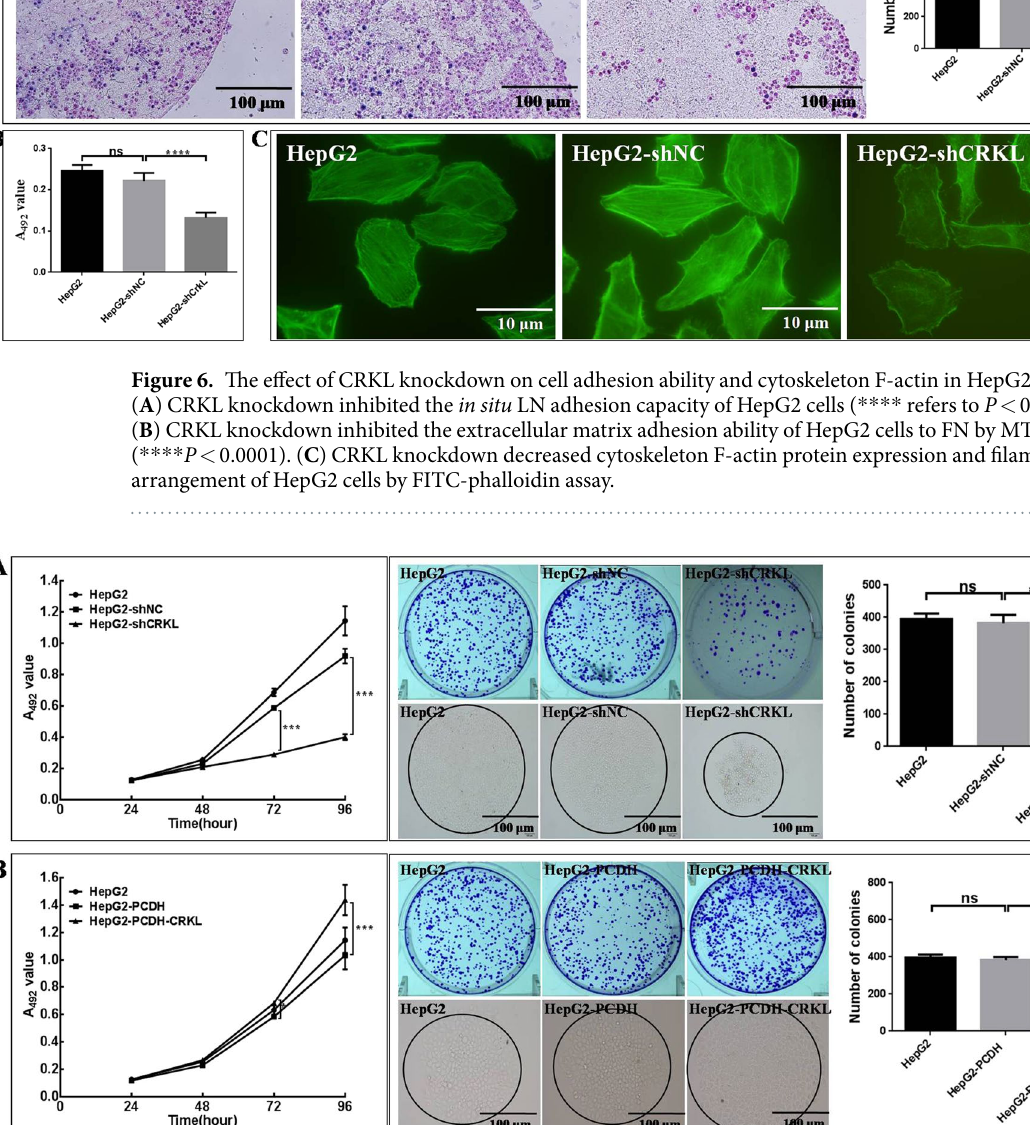
and increased N-cadherin (Fig. 9C) and Vimentin expression (Fig. 9D). miR-429 and CRKL are involved in the EMT of HCC. c-Jun signaling pathway is critical for cell growth. CRKL knockdown decreased and overexpression increased the mRNA level of c-Jun , while miR-429 overexpression and silencing showed no influence on c-Jun expres- sion (Fig. 10). Interestingly, CRKL knockdown or overexpression significantly decreased or increased the protein expression levels of c-Jun, p-c-Jun (73), p-c-Jun (243), JNK, p-JNK by 57.7%, 56.1%, 45.2%, 3.6-fold or 4.4-fold, 6.0-fold, 3.6-fold, 78.7%, 1.9-fold (Fig. 10). While, miR-429 overexpression or silencing only slightly decreased or increased the protein levels of c-Jun, p-c-Jun (73), p-c-Jun (243), JNK, p-JNK by 26.1%, 43.2%, 27.5%, 12.1%, 35.1% or 23.0%, 49.2%, 52.3%, 12.7%, 15.9% (Fig. 10). Our results showed that the deregulate degree of miR-429 on c-Jun pathway was significantly weaker than CRKL, this difference might contribute to explain our previous results that the overexpression or silencing of miR-429 rarely influenced the proliferation and colony formation